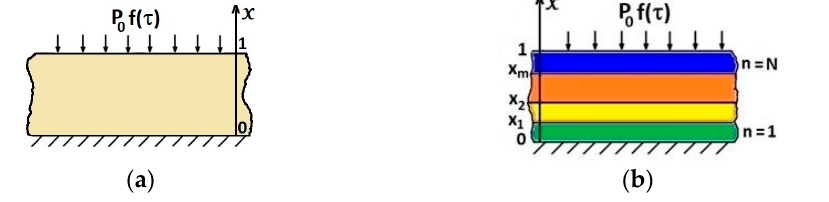
Figure 1. Loading of the layer’s cross section. ( a ) FG layer; ( b ) piecewise-homogeneous layer.